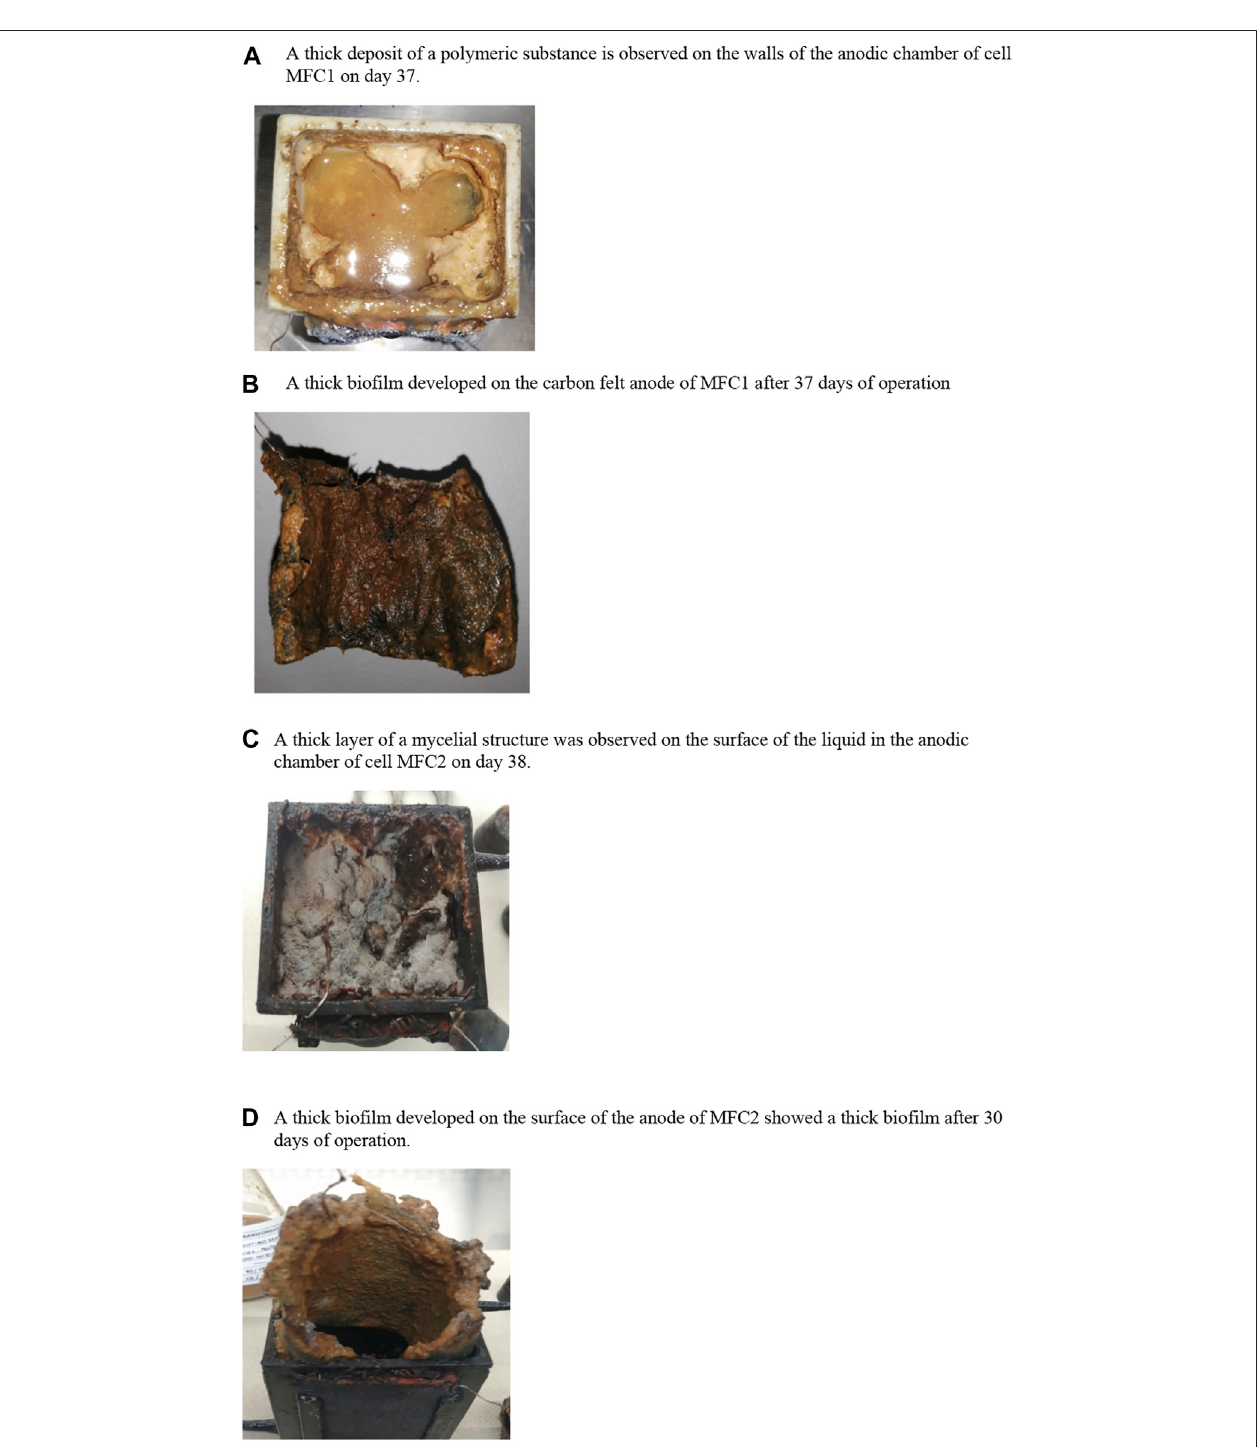
FIGURE 7 | Macroscopic changes observed in the anodic chamber of MFCs. (A) A thick deposit of a polymeric substance is observed on the walls of the anodic chamber of cell MFC1 on day 37. (B) A thick bio fi lm developed on the carbon felt anode of MFC1 after 37 days of operation. (C) A thick layer of a mycelial structure was observed on the surface of the liquid in the anodic chamber of cell MFC2 on day 38. (D) A thick bio fi lm developed on the surface of the anode of MFC2 showed a thick bio fi lm after 30 days of operation.